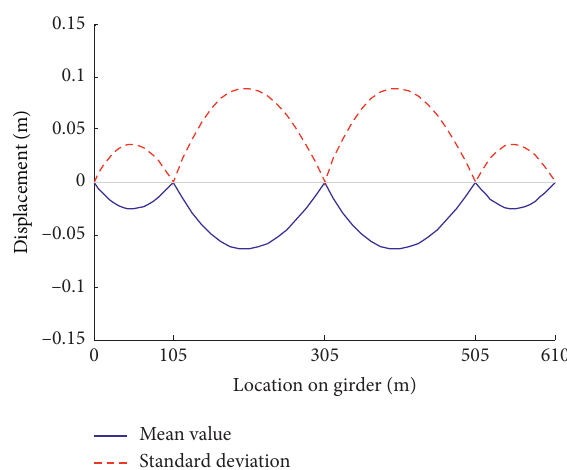
Figure 15: Trends of mean value and root mean square of displacement along the